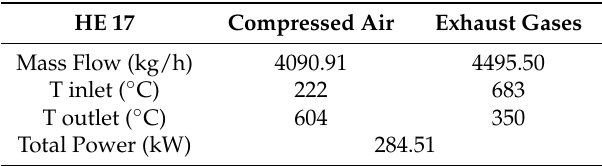
Table 8. Compressed air preheating process.